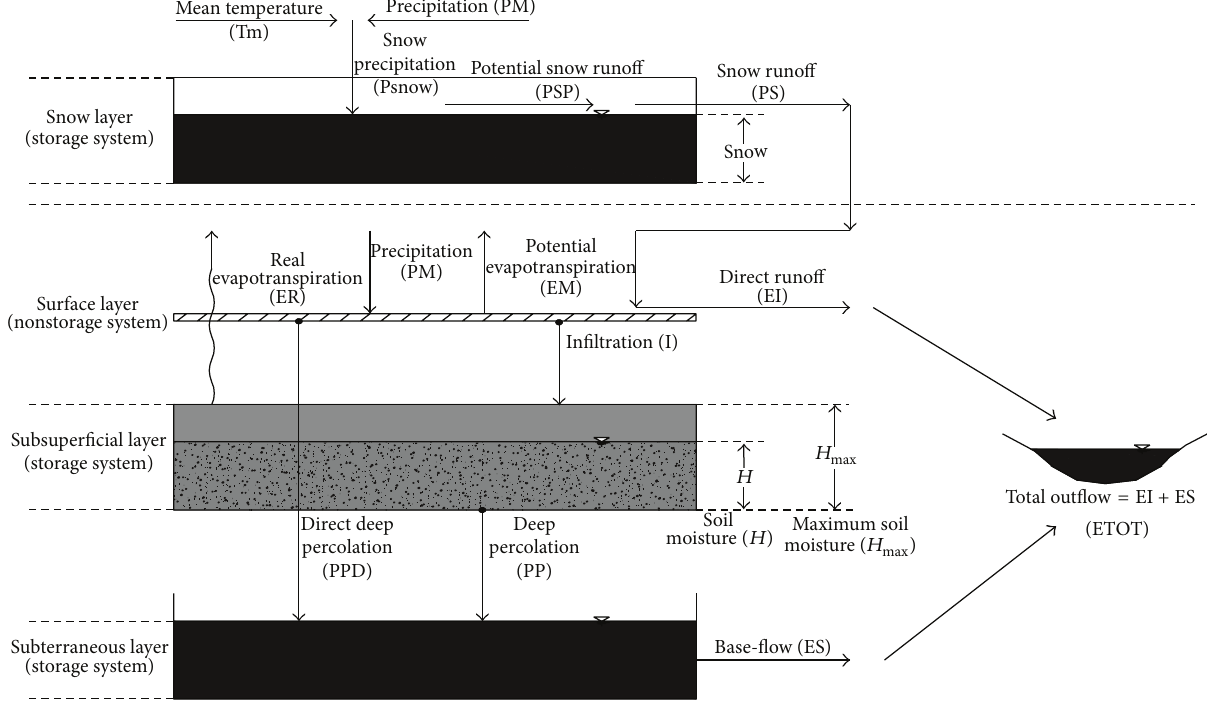
Figure 2: Conceptual